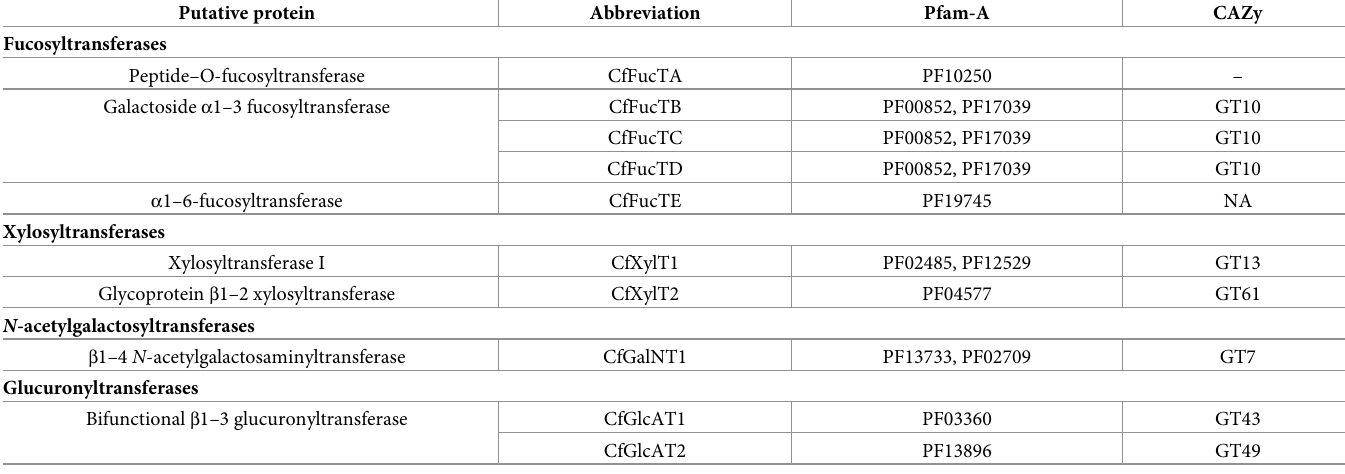
Table 5. Select putative Cardicola forsteri glycosyltransferases with their predicted structural domains. Putative